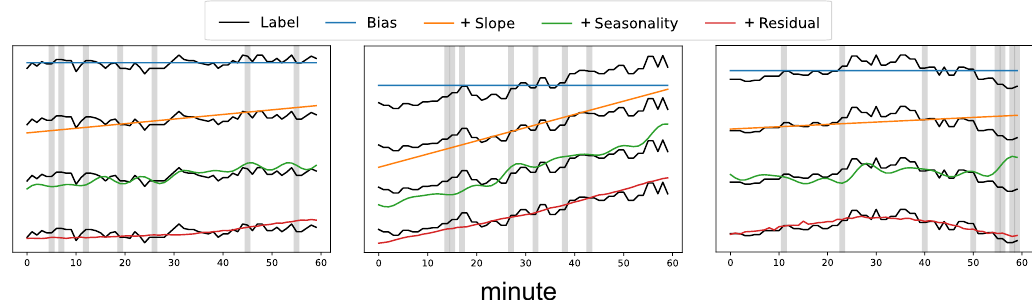
Figure 4. Cumulative prediction results of the bias, slope, seasonality, and residual blocks. The results are obtained with PM 2.5 test data collected at Guro-gu. Label denotes the original time-series without missing